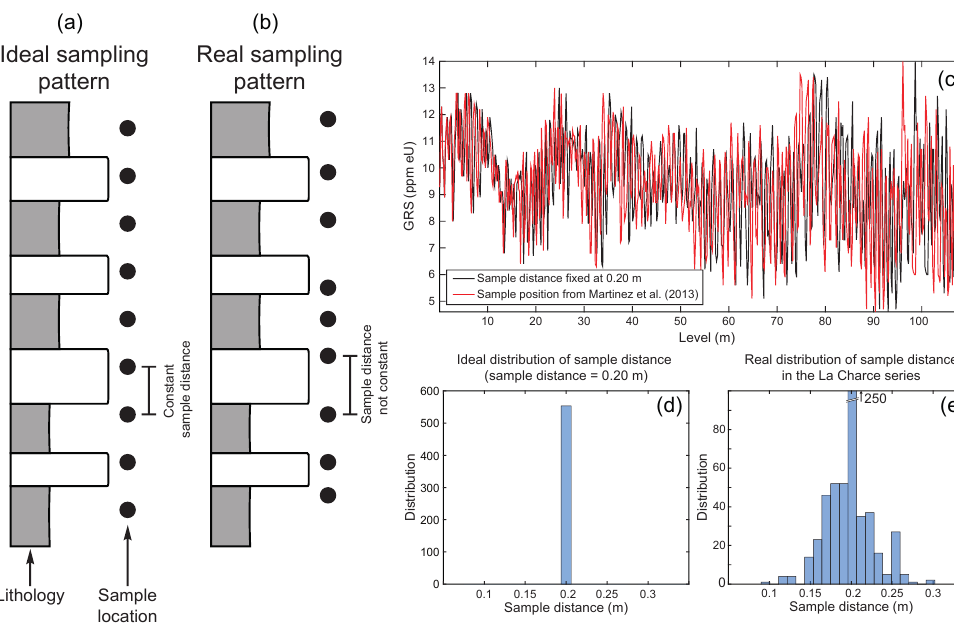
Figure 1. Illustration of the problem. (a) Theoretical sedimentary log with position of samples in an ideal case in which the samples are strictly equally distant. (b) Theoretical sedimentary log with position of samples in a common sampling pattern where all samples are not strictly equally distant. Here the error in the sample position is exaggerated for the purpose of the example. (c) The gamma-ray series from La Charce shown as if all samples were strictly equidistant (black curve) and as they are positioned in Martinez et al. (2013) (red curve). (d) Distribution of sample distances in the case of ideal sampling of the La Charce series (all sample distances are fixed at 0.20m). (e) Distribution of sample distances in the case of the La Charce series as published in Martinez et al.